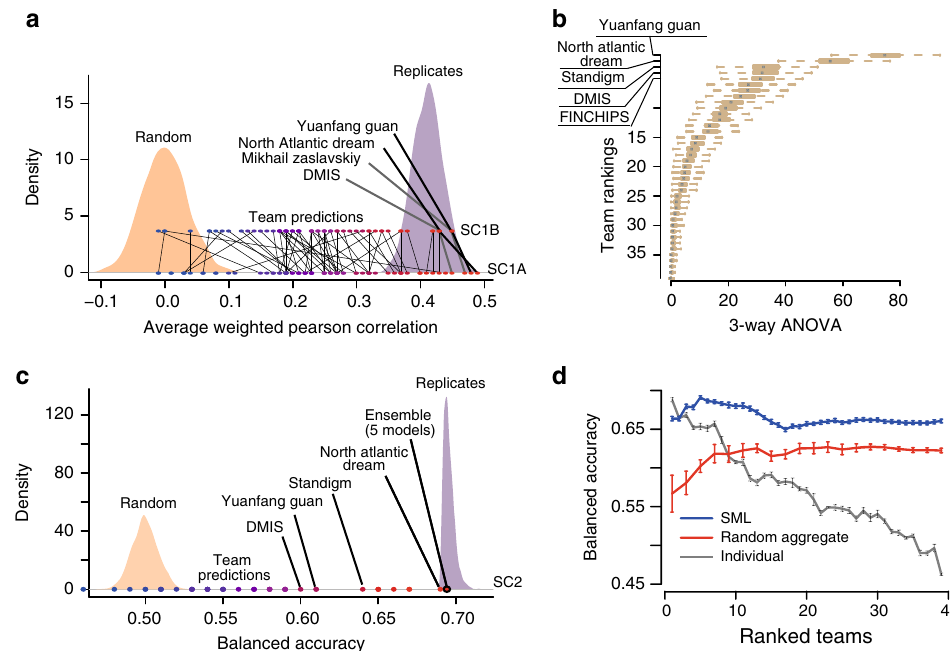
Fig. 3 Performance of teams in the AstraZeneca-DREAM challenge. a Participant performance in SC1A and SC1B — the distribution of performance of random predictions was used to estimate a lower limit, and the distribution of synergy correlations between biological replicates were used to estimate the upper limit. b Participant performance ranked in SC2 based on the primary metric, 3-way ANOVA. Distribution of bootstrap prediction performances for each team are shown by each boxplot with the dot showing their actual performance. c Participant performance plotted with upper and lower limits for SC2 based on the tie-break metric. d Ensemble models compared to the performance of individual models ranked from best to poorest performing in SC2. SML is an ensemble of the best performing models based on estimation of their BAC. Random Aggregation is an ensemble combining a random combination of models. Standard error of mean represented by error bars are estimated from ten random splits of the